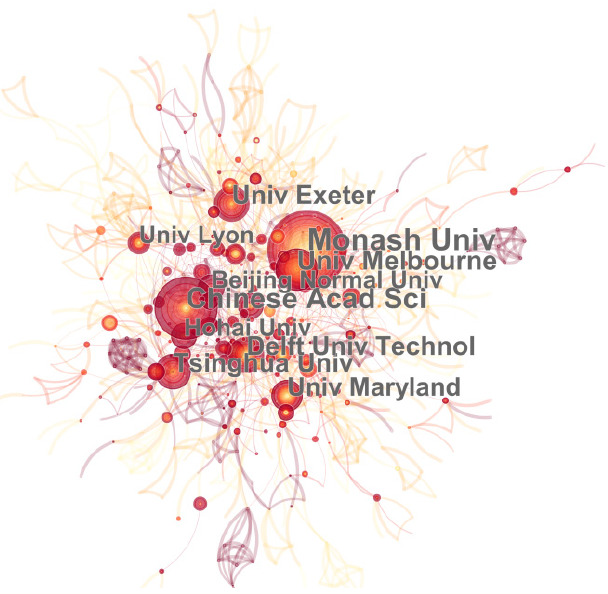
Figure 5. Institutional cooperation network.